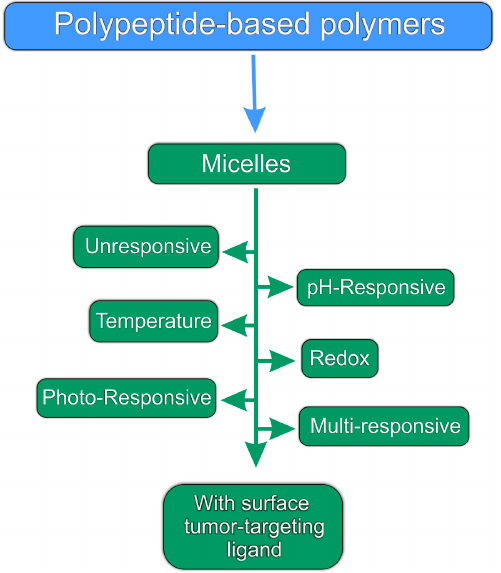
Figure 1. Structure of the smart aggregates formed by polypeptide-containing polymers presented in this review.